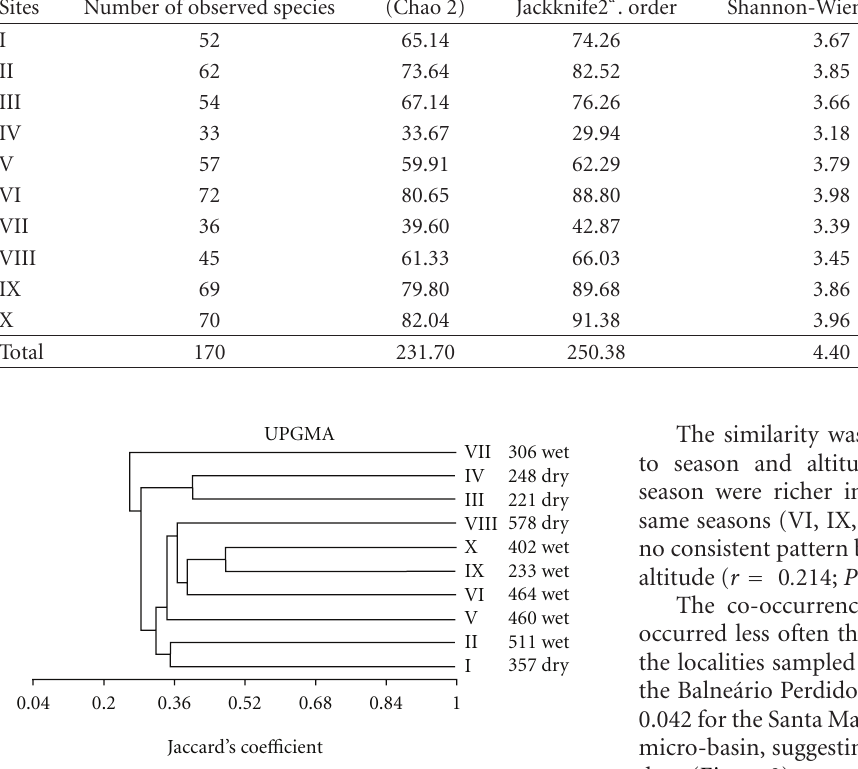
Figure 7: Dendrogram of the similarities (Jaccard coe ffi cient, UPGMA cluster analysis) among 10 sampling sites in the Bod- oquena mountain range to leaf-litter ant’s fauna. Wet and dry mean seasons, and numbers mean altitude (als).